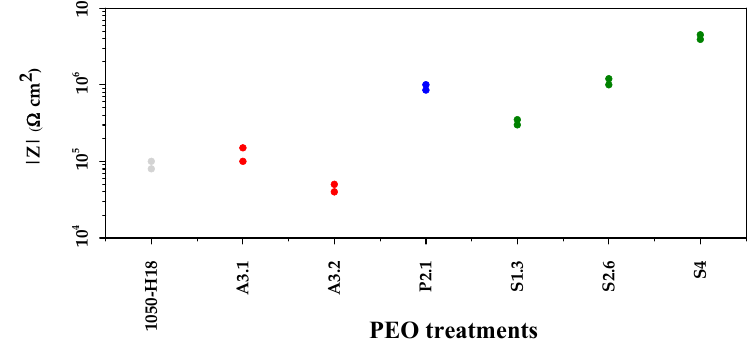
Figure 1. Scatter diagram of impedance modulus at 10 − 2 Hz; selected PEO coatings on AA1050 alloy,